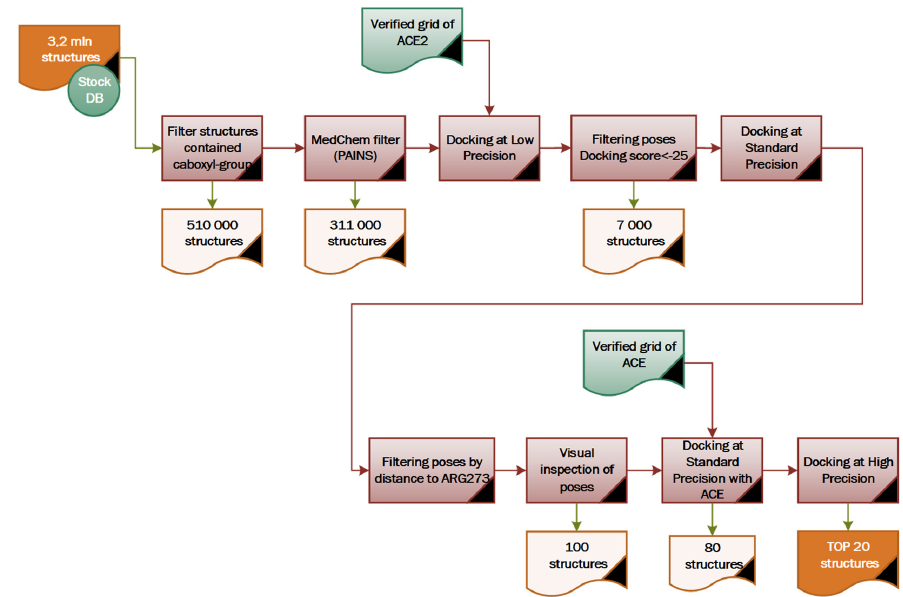
Figure 6. Virtual screening workflow for Enamine SCC (3.2 million compounds).